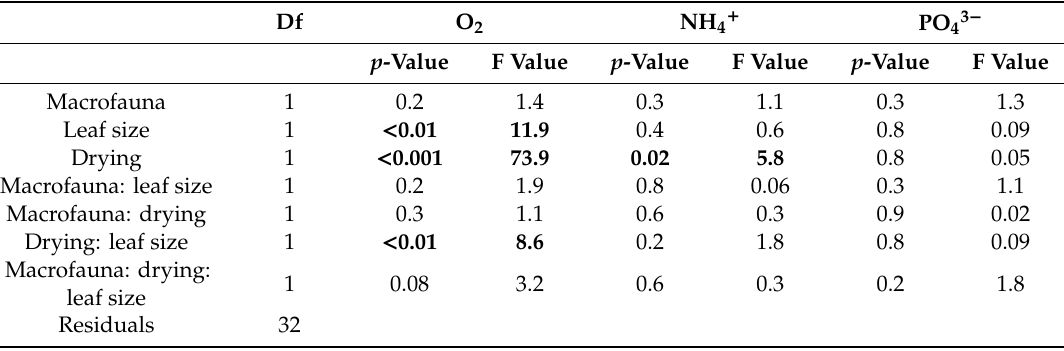
Table 2. Summary of results of three-way ANOVA testing the e ff ects of factors macrofauna, leaf size and drying on benthic respiration (O 2 ) and nutrient fluxes (NH 4 + , PO 43 − ) measured on day 33. Significant values are printed in